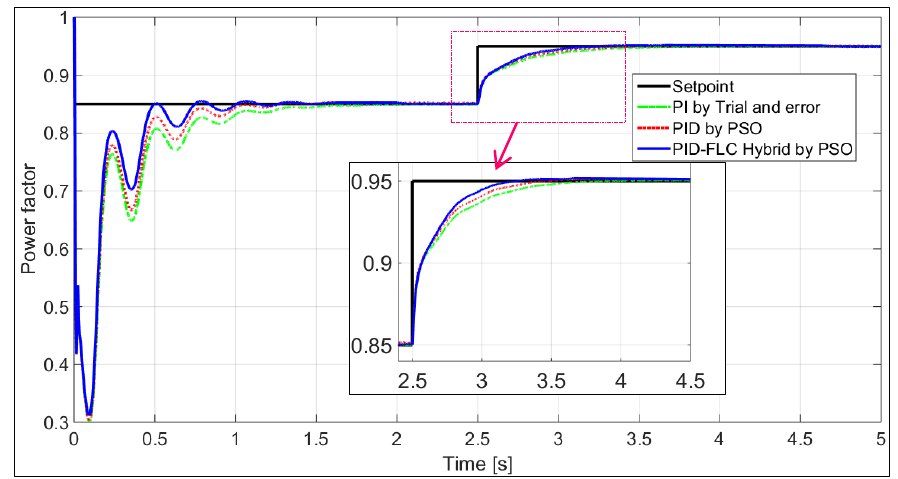
Figure 17. Response of cos  when cos  _ref = 0.95 and load in increased 30% at t = 2.5s